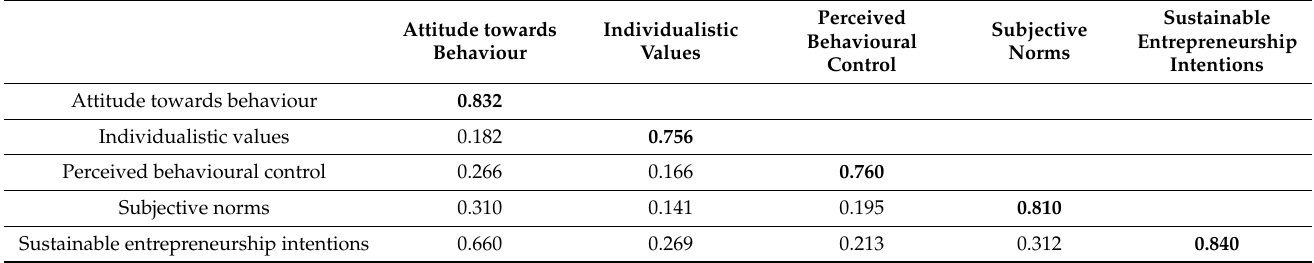
Table 5. Fornell–Larcker